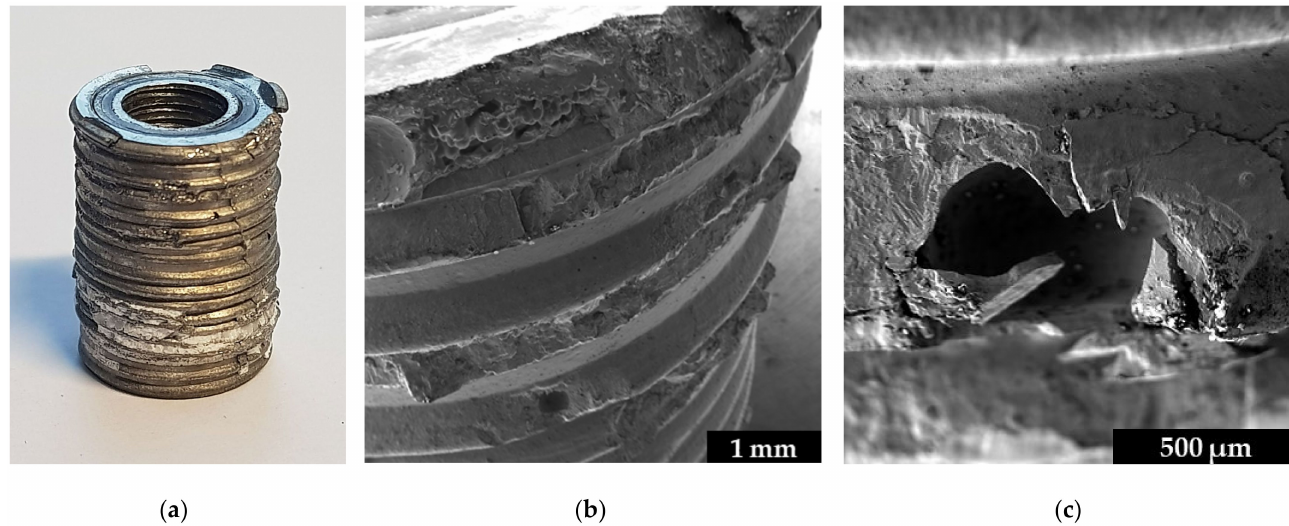
Figure 13. Fractographic images of the whole titanium insert, including ( a ) ceramic fragments, ( b ) the failed brazed seam in the upper part, and ( c ) a broken